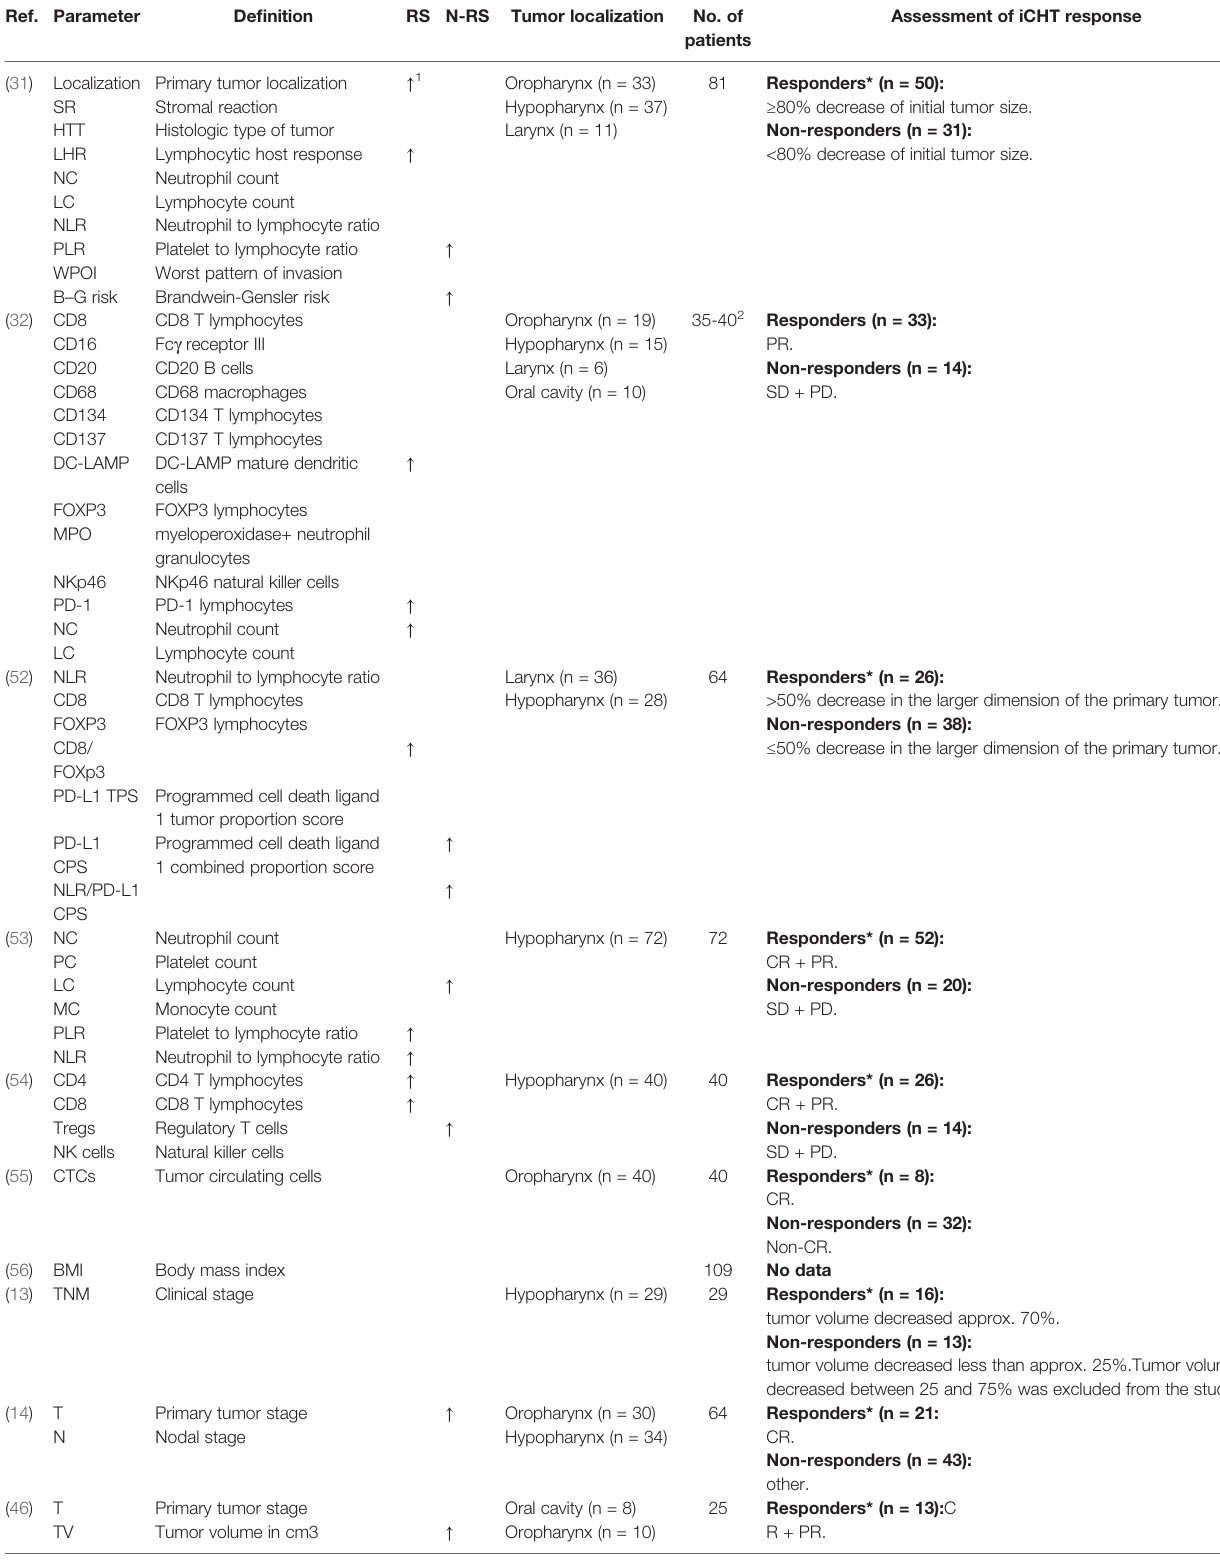
TABLE 4 | Summary of studies analyzing clinicopathological parameters in regard of predicting iCHT response. Ref.